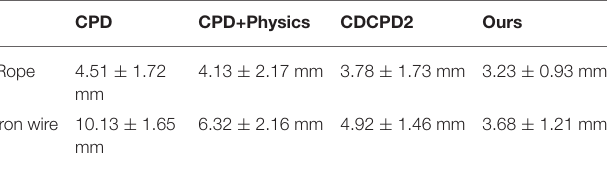
TABLE 1 | Mean distance error.